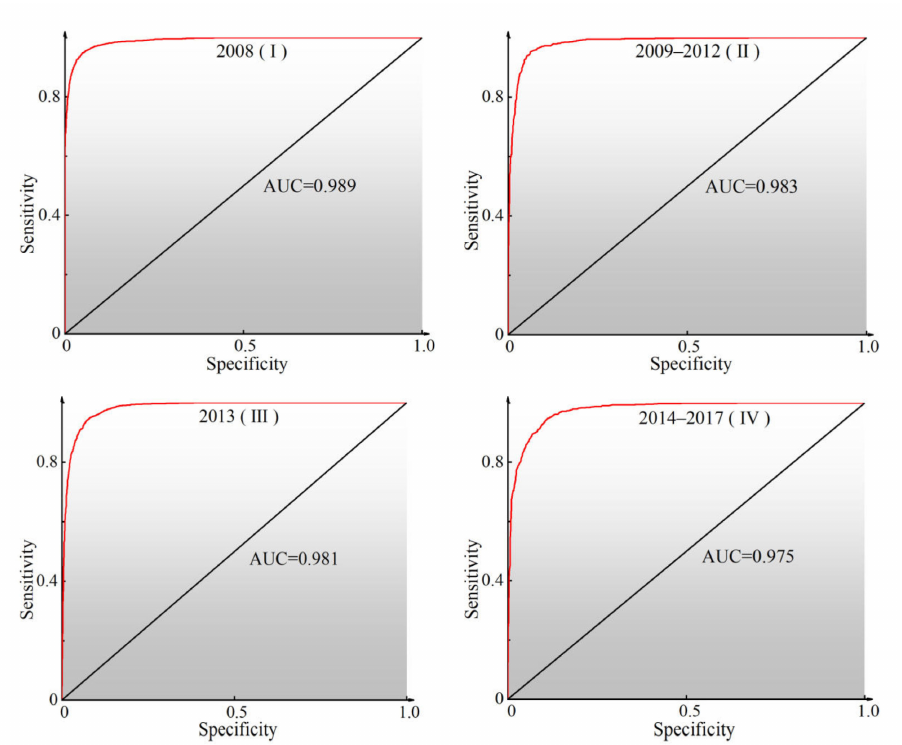
Figure 5. ROC curve and AUC value in four periods.